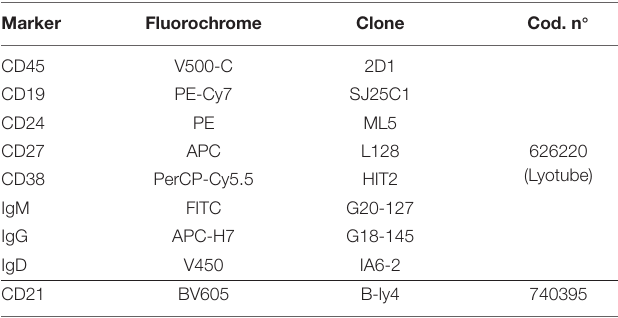
TABLE 1 | Antibodies used for the staining of the peripheral blood and the identification of B-cell subsets.